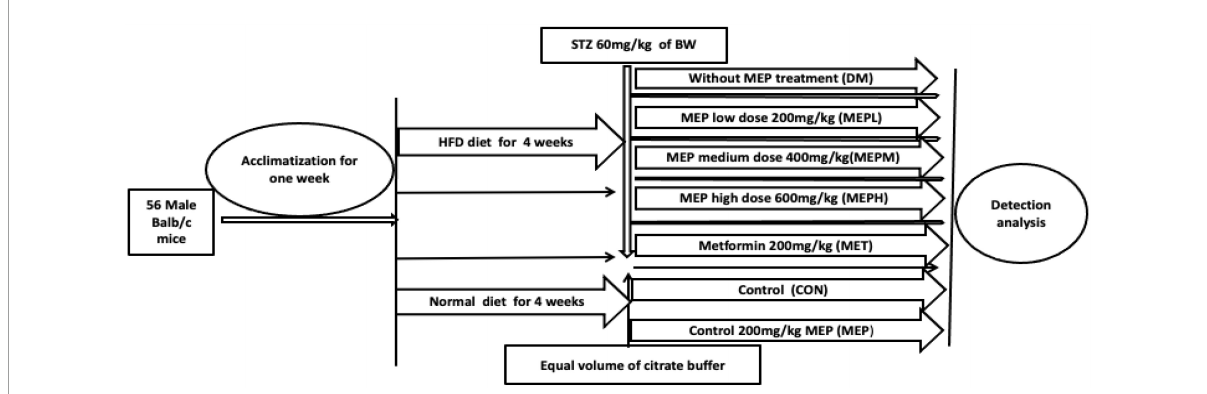
FIGURE1 Experimental plan and design. The TD2M mouse model was developed by giving a HFD for 4 weeks, followed by intraperitoneal injections of STZ at 60 mg/kg on an overnight fast every fifth day for 8 weeks. The T2DM mice were divided into five groups ( n = 8 in each group): no MEP treatment: 200 mg/kg metformin (MET); 200 mg/kg MEP low dose (MEPL); 400 mg/kg MEP medium dose (MEPM); and 600 mg/kg MEP high dose (MEPH). The 16 control mice were divided into two groups ( n = 8). One was given PBS as control (CON), and the other was given 200 mg/kg